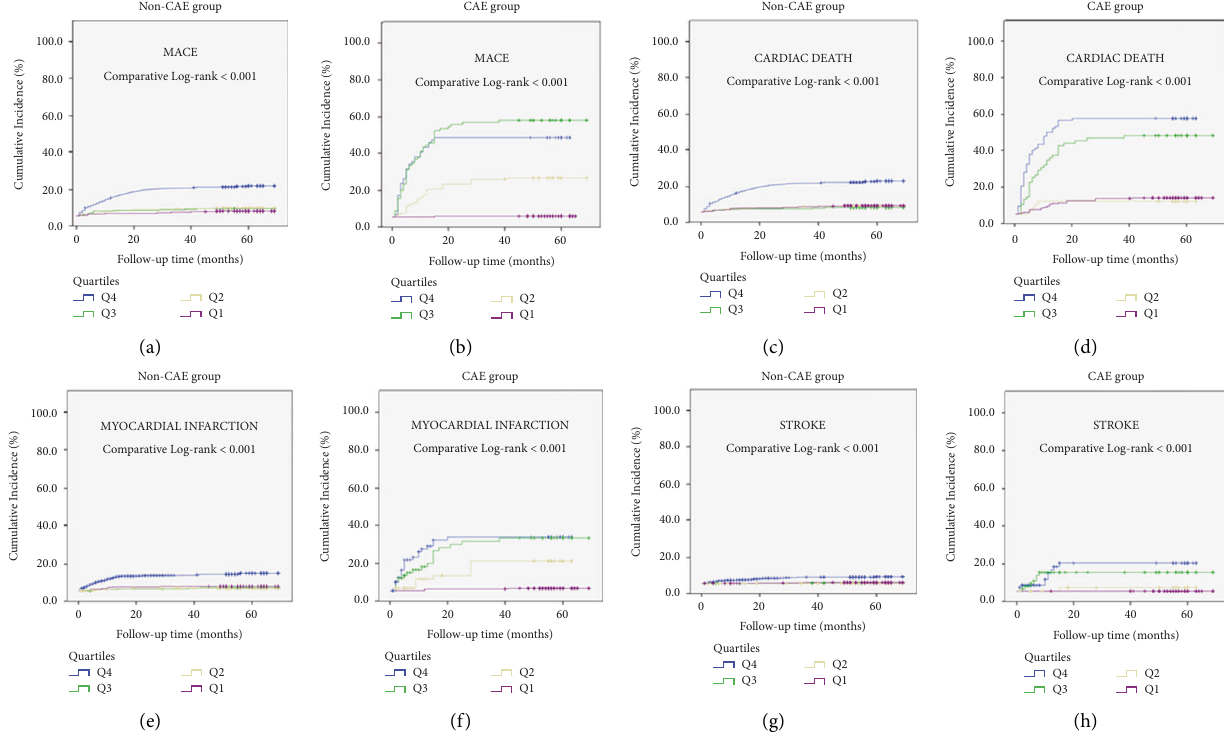
Figure 8: Kaplan–Meier survival curves of cumulative incidence of MACE (a-b); cardiac death (c-d) myocardial infarction (e-f); and stroke (g-h) in patients with CAE and without CAE according to their C-peptide quartiles (Q4-blue line; Q3-green line; Q2-yellow line; Q1-purple line); CAE: coronary artery ectasia; MACE: major adverse cardiovascular